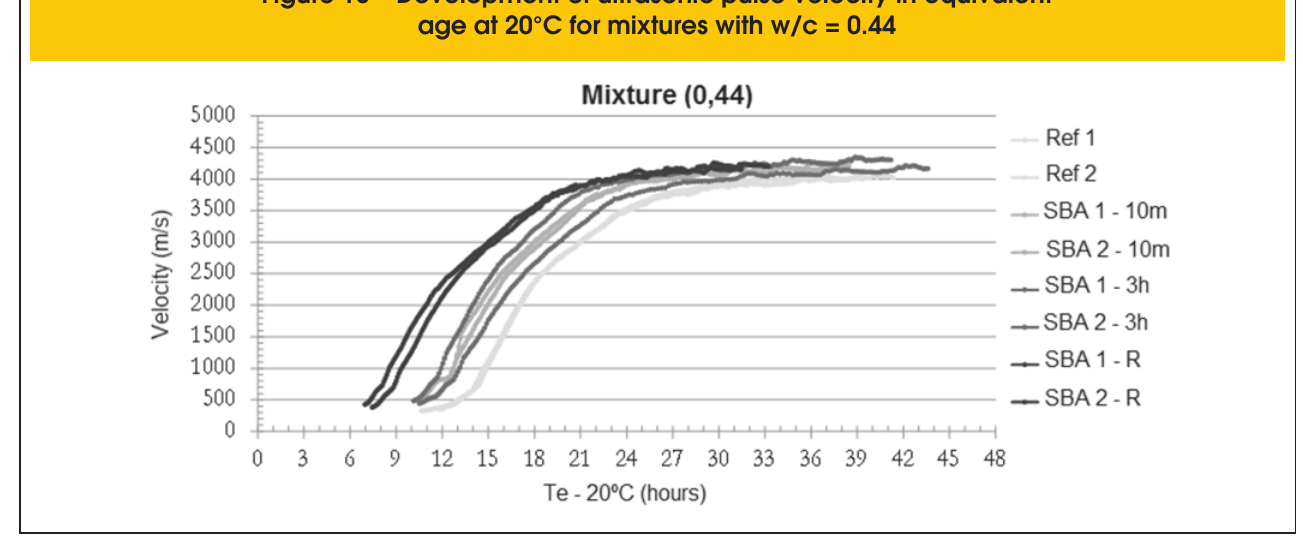
Figure 13 – Development of ultrasonic pulse velocity in equivalent age at 20°C for mixtures with w/c = 0.44